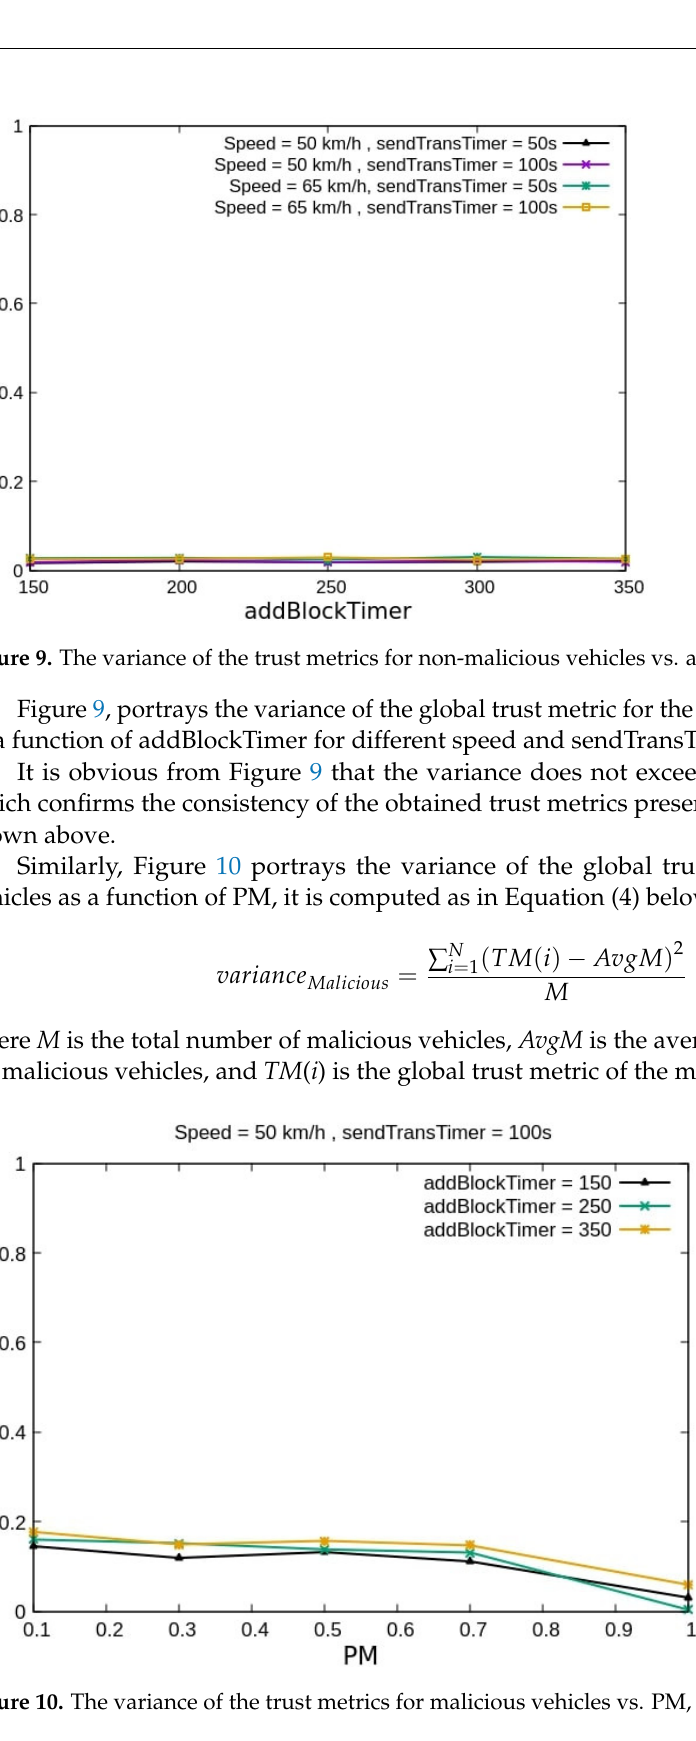
12 Figure 8. The average trust metric of malicious vehicles vs. the percentage of malicious vehicles in the network. Now we focus on the consistency of the computed trust metrics stored in the block- chain. To this end, Figure 9 presents the variance of the global trust metrics for non-mali-